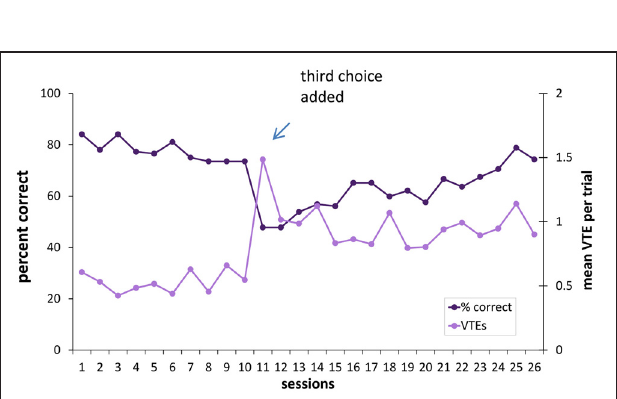
FIGURE 8 | Three-choice visual discrimination performance and VTEs. (A) Over 16 sessions of testing, performance on the three-choice discrimination improved, although no significant difference between the